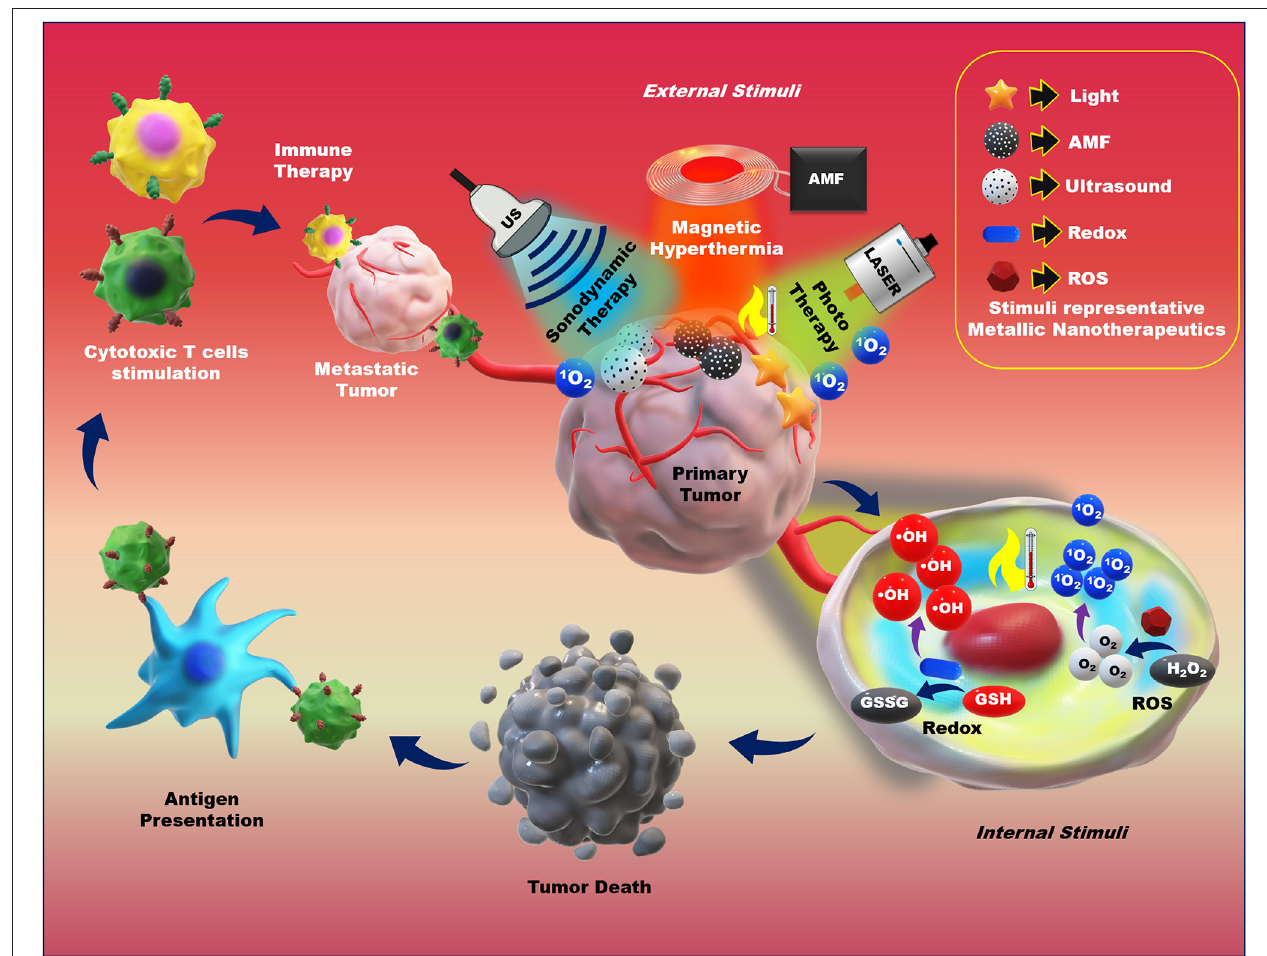
FIGURE 6 | Application of external and internal stimuli-triggered metallic nanotherapeutics for cancer therapy. Different stimuli such as light, an alternative magnetic field (AMF), ultrasound (US), redox, and reactive oxygen species (ROS) trigger metallic nanotherapeutics to exert their anticancer activities. External stimuli such as light, AMF, and US induce phototherapy, magnetic hyperthermia, and sonodynamic therapy, whereas internal stimuli such as redox and ROS promote toxic radical production, resulting in tumor death. Antigens are released upon tumor death and captured by antigen-presenting cells, which further trigger cytotoxic immune cell activation against metastatic